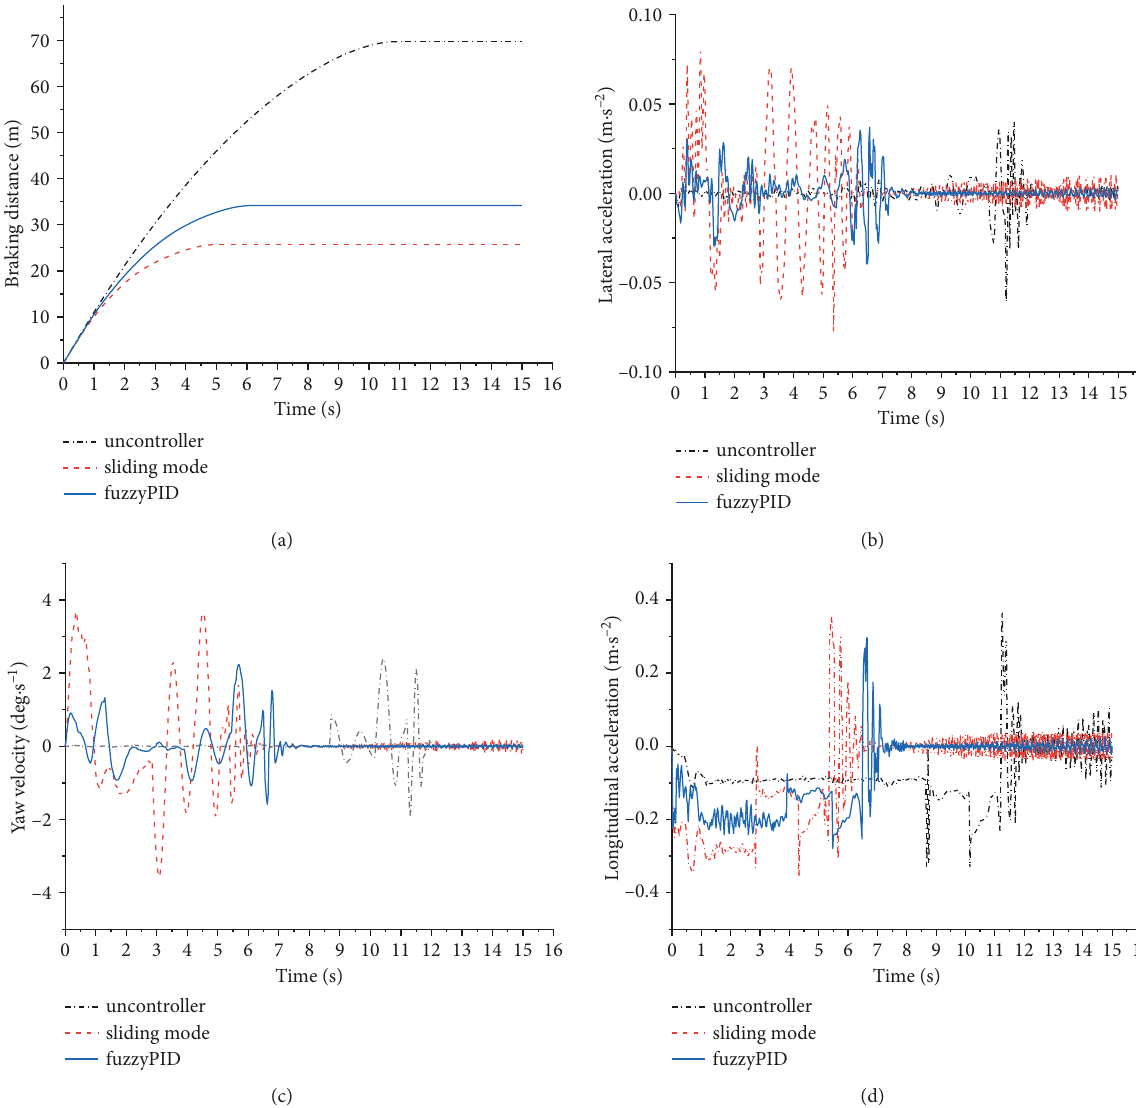
Figure 14: Simulation comparison diagram of different controls in long downhill with u � 0.7. (a) Braking distance. (b) Lateral acceleration. (c) Yaw velocity. (d) Longitudinal